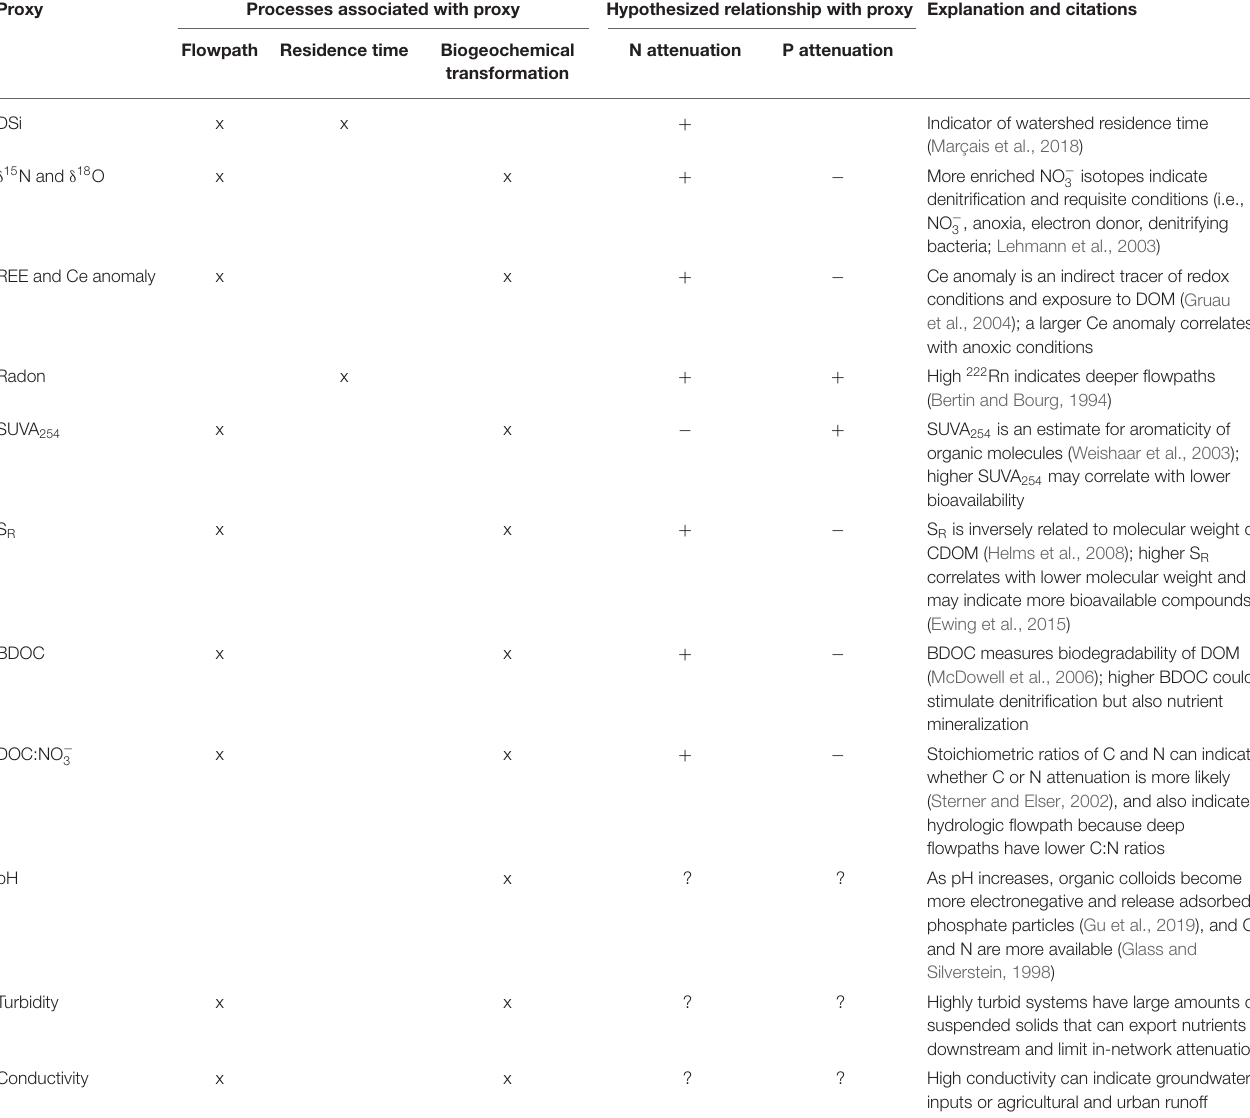
TABLE 1 | List of proxies in our analysis and predictions of how they might affect nutrient attenuation. Proxy Processes associated with proxy Hypothesized relationship with proxy Explanation and citations Flowpath Residence time Biogeochemical N transformation